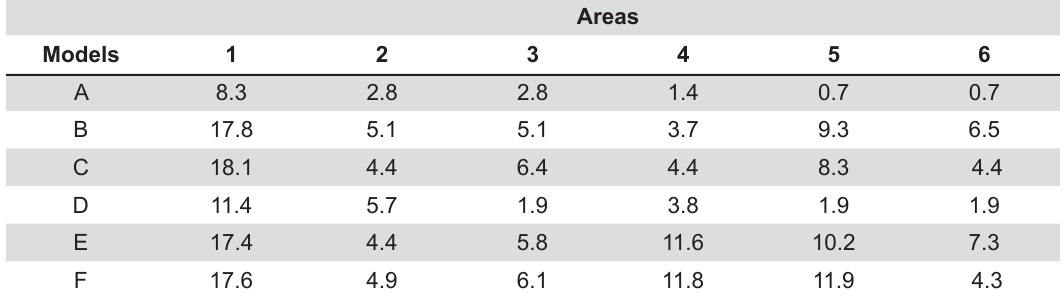
), in MPa, for the medullar bone according to specific areas (1 to 6) in the models (A to Table 3- von Mises stress ( s vM